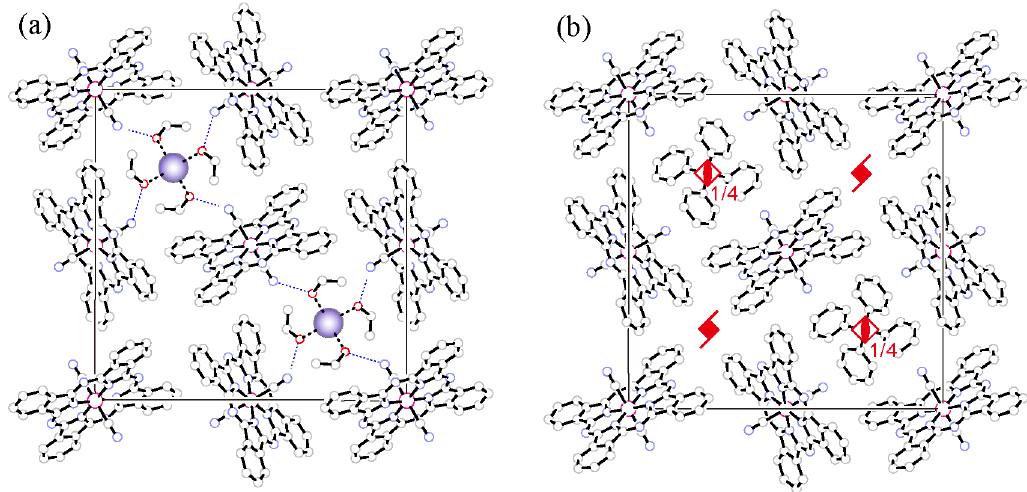
.4(EtOH) and ] 2 2 / n 2